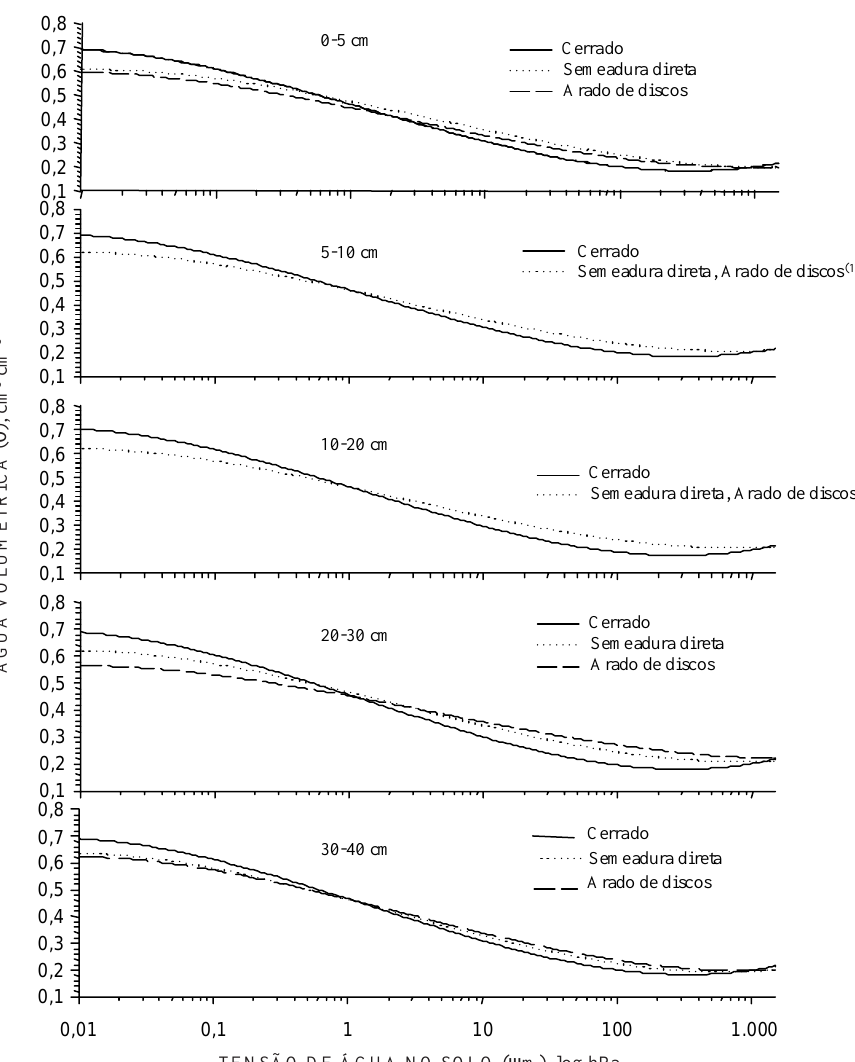
TENSÃO DE ÁGUA NO SOLO ( y m), log Figura 2. Curva característica de água de cinco profundidades do Latossolo Vermelho sob Cerrado, semeadura direta e preparo com arado de discos. (1) curvas são idênticas.